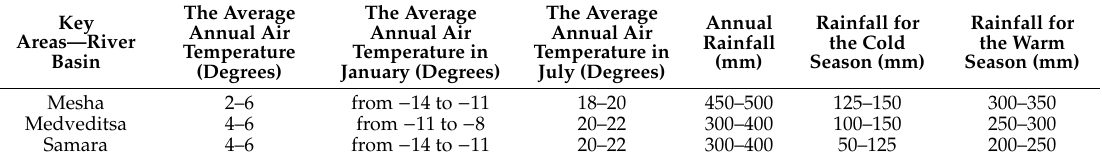
Table 1. The climatic parameters in the river basins Mesha, Medveditsa and Samara